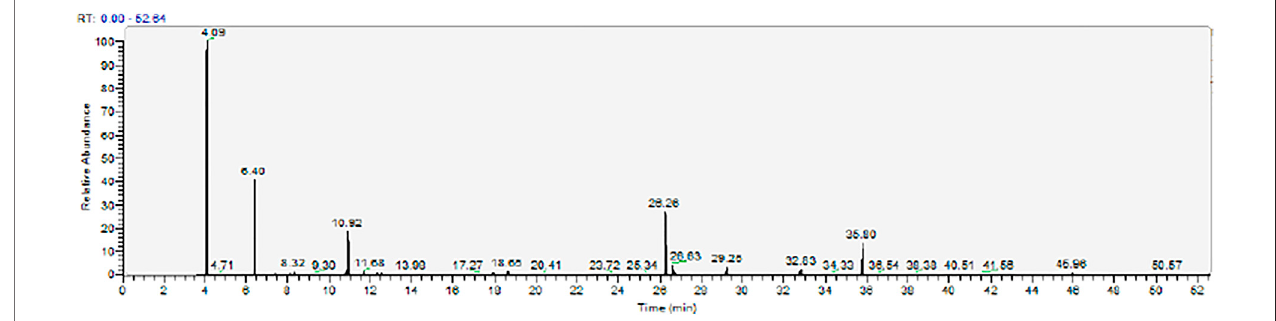
FIGURE 1 | Representative TIC of the plasma